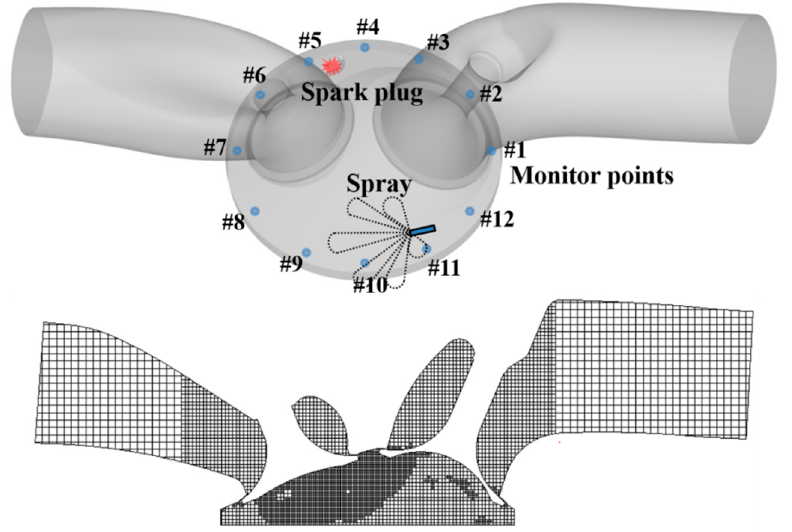
Figure 2. Schematic of the model structure and grid splitting.